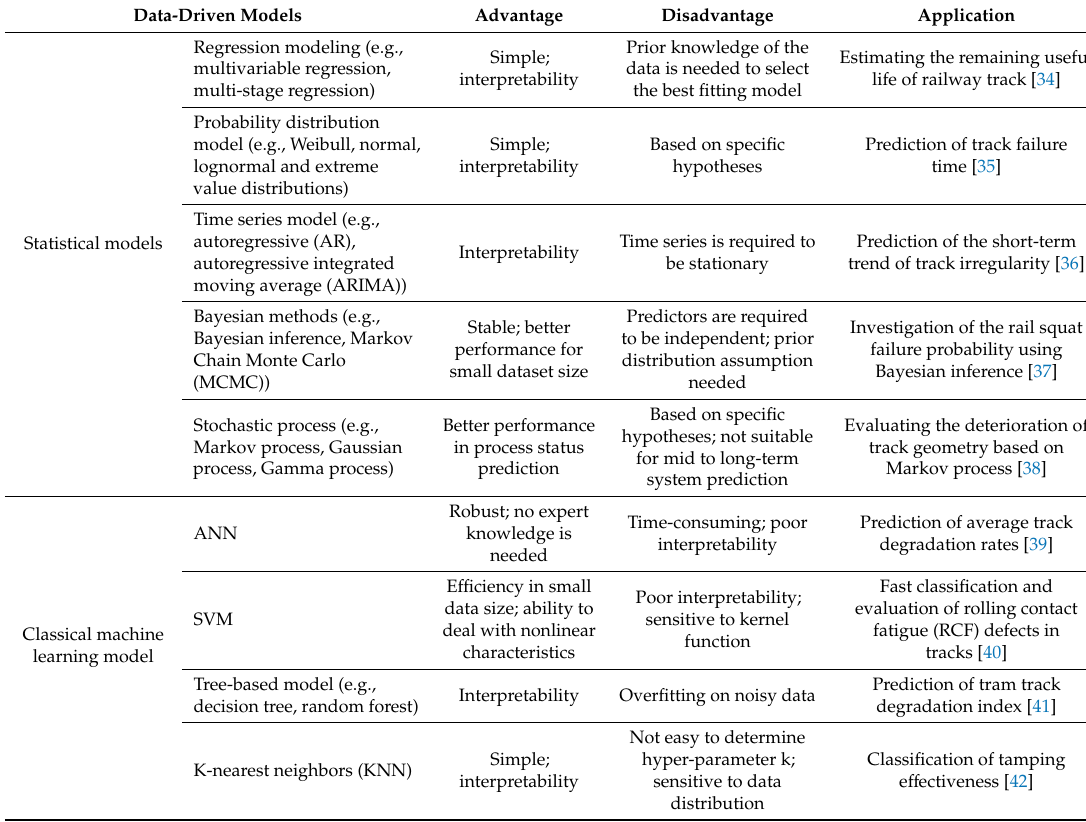
Table 3. Classical data-driven models in predictive maintenance of railway